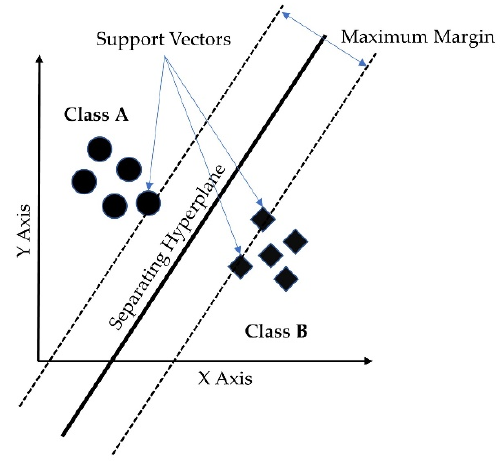
Figure 6. Support vector machine hyperplane for binary classification.